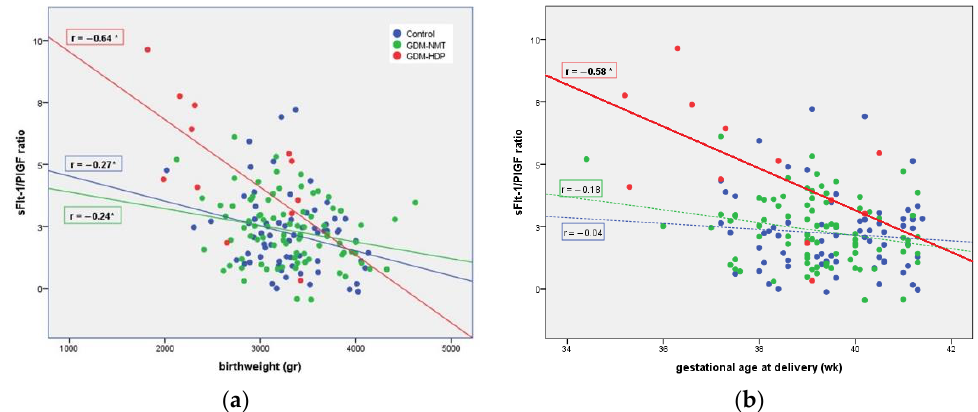
Figure 3. The correlations of plasma sFlt-1/PIGF ratio according to the birthweight ( a ) and the gestational age at delivery ( b ). ( a ) Correlation between the sFlt-1/PIGF ratio and birthweight. * p < 0.05. ( b ) Correlation between the sFlt-1/PIGF ratio and gestational age at delivery. * p < 0.05.